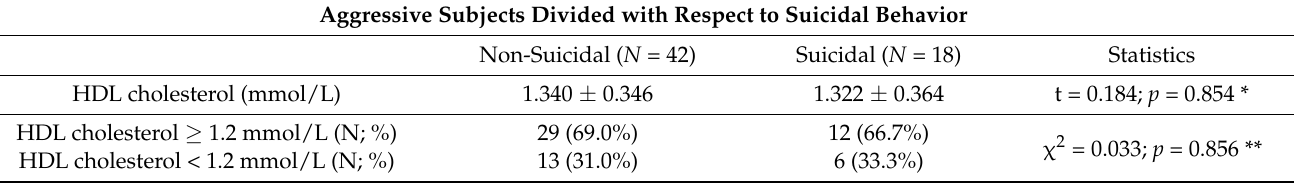
Table 5. HDL cholesterol concentration in aggressive subjects depending on suicidal behavior.